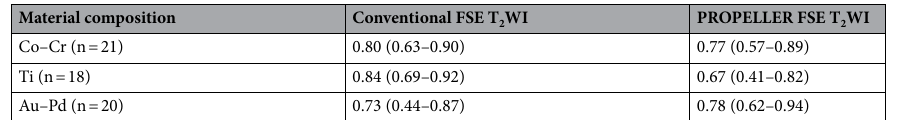
Table 1. Interrater agreement for image qualitative scores in conventional FSE T 2 WI and PROPELLER FSE T 2 WI sequences. Interreader variability is statistically significant ( P < 0.001); FSE T 2 WI, fast spin echo T 2 weighted imaging; PROPELLER FSE T2WI, periodically rotated overlapping parallel lines with enhanced reconstruction fast spin echo T2 weighted imaging; Co–Cr, cobalt-chromium; Ti, titanium; Au–Pd, gold–